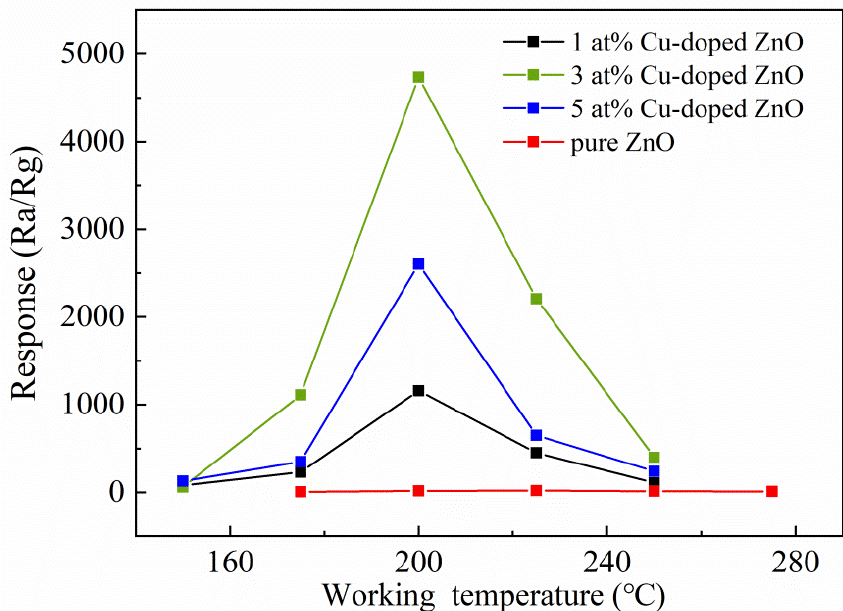
Figure 5. Response curves of ZnO nanocages with different Cu contents with respect to H 2 S at different operating temperatures.